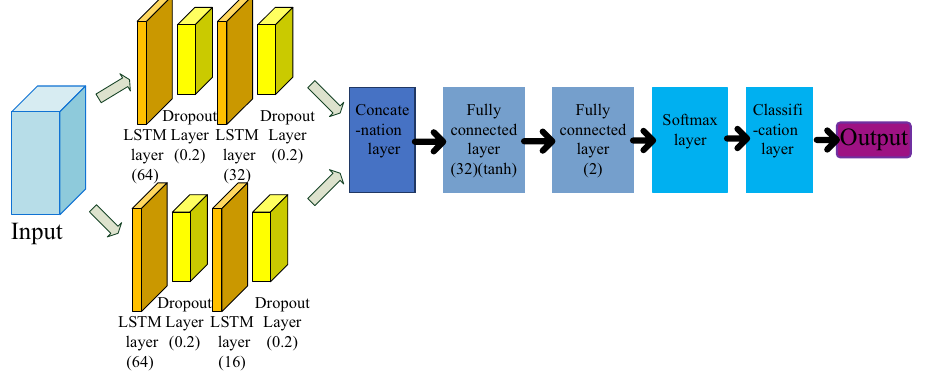
Figure 3. Multi-step ahead thermal warning network